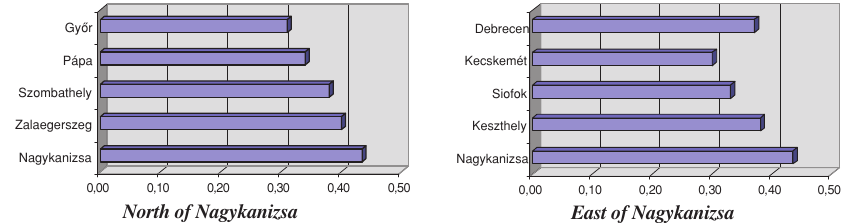
North of Figure 3. The well balanced precipitation indexes across the country, 1951–2009